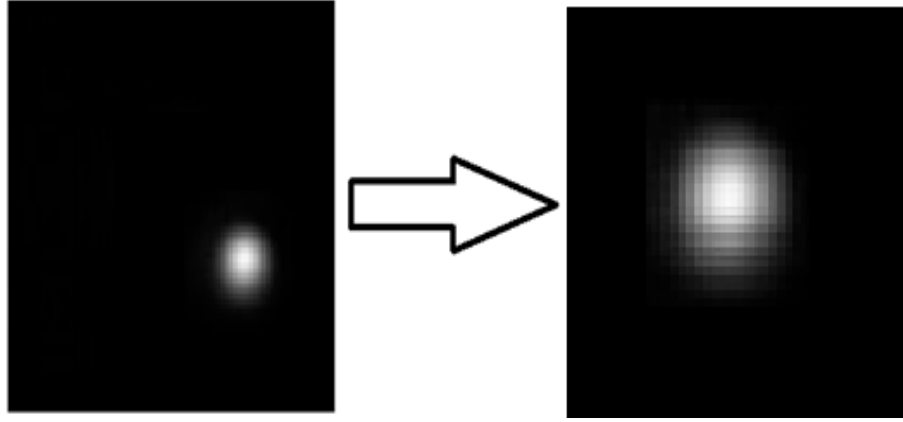
Figure 2. Schematic diagram of laser spot positioning.